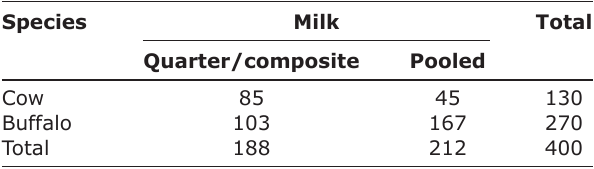
Table-1: Details of the milk samples collected for the study.